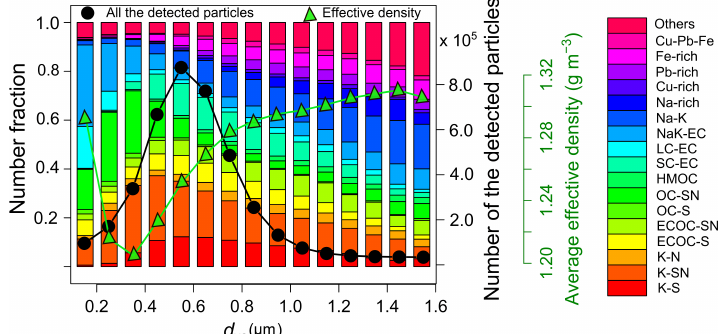
Figure 5. Number fraction, number of all the detected particles, and the estimated average ρ eff of each particle type as a function of d va